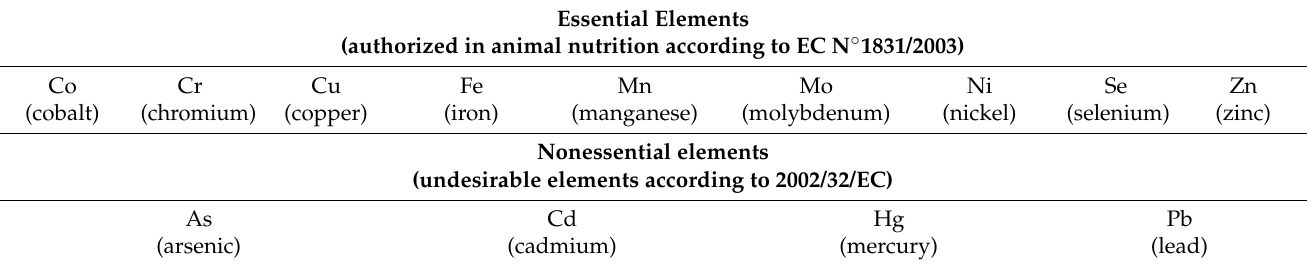
Table 1. Heavy metals in animal nutrition